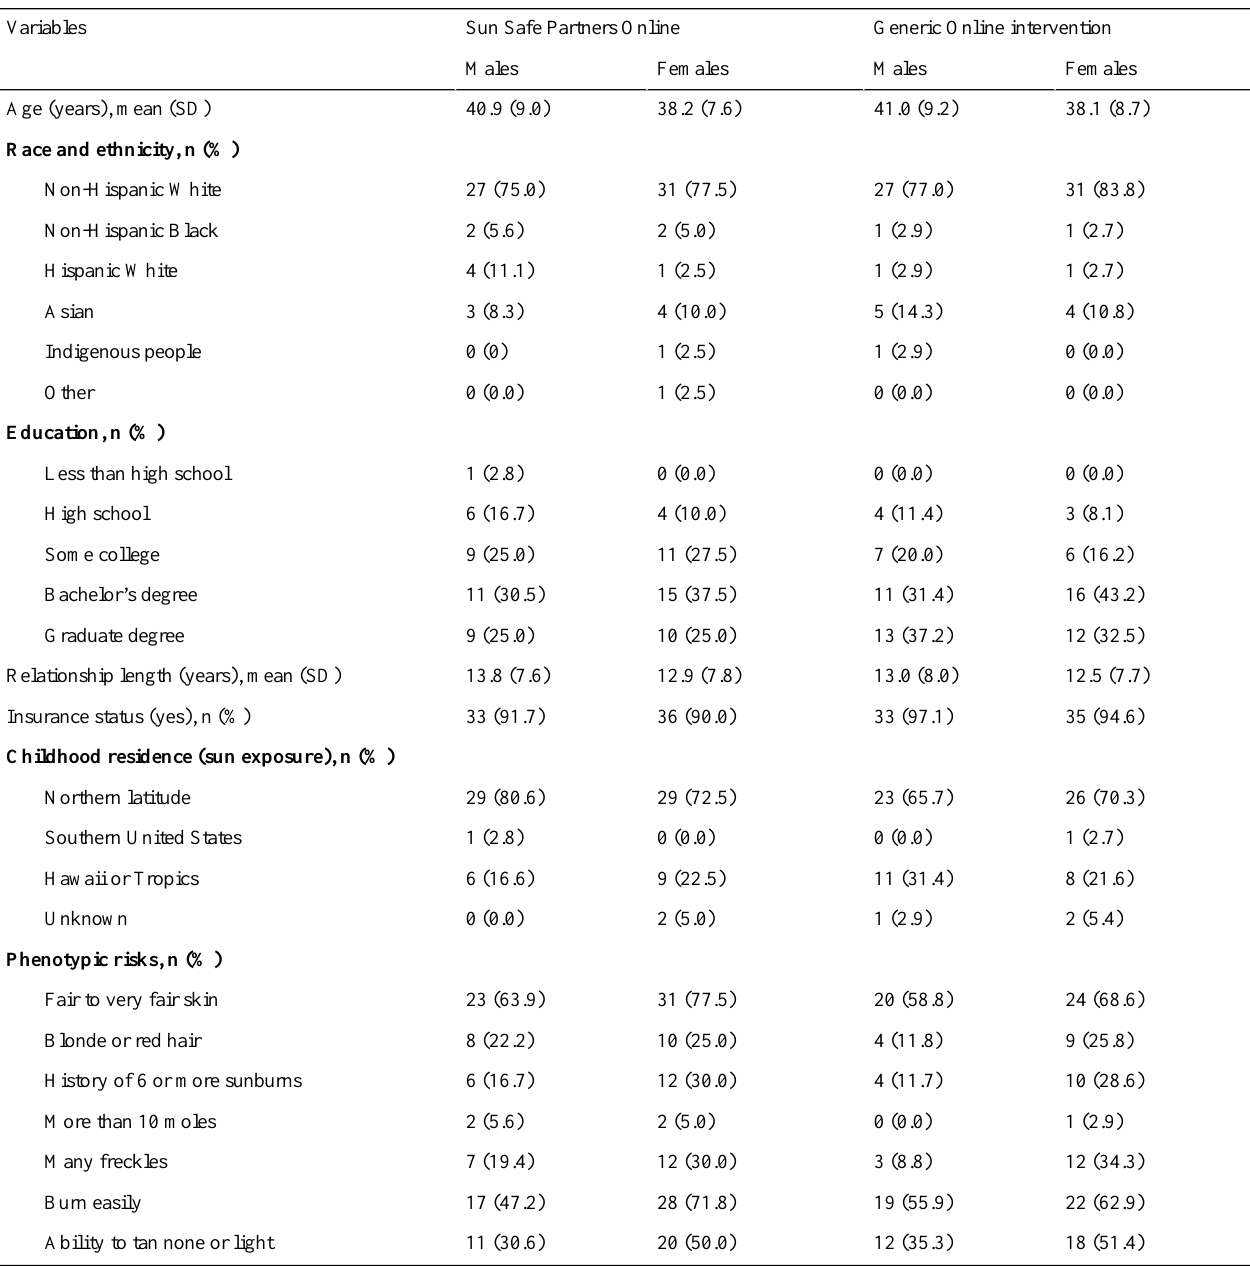
Table 3. Descriptive information for the study sample.